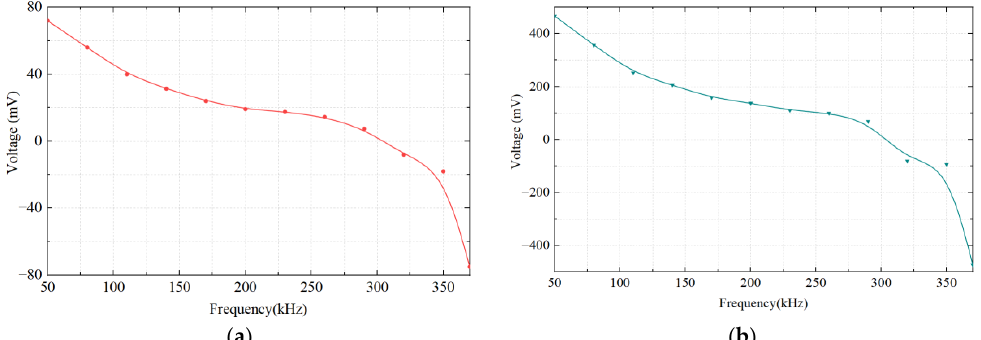
Figure 11. The relationship between output voltage and excitation frequency of ferrous metal parti- cles. ( a ) 245 μm ; ( b ) 480 μm .